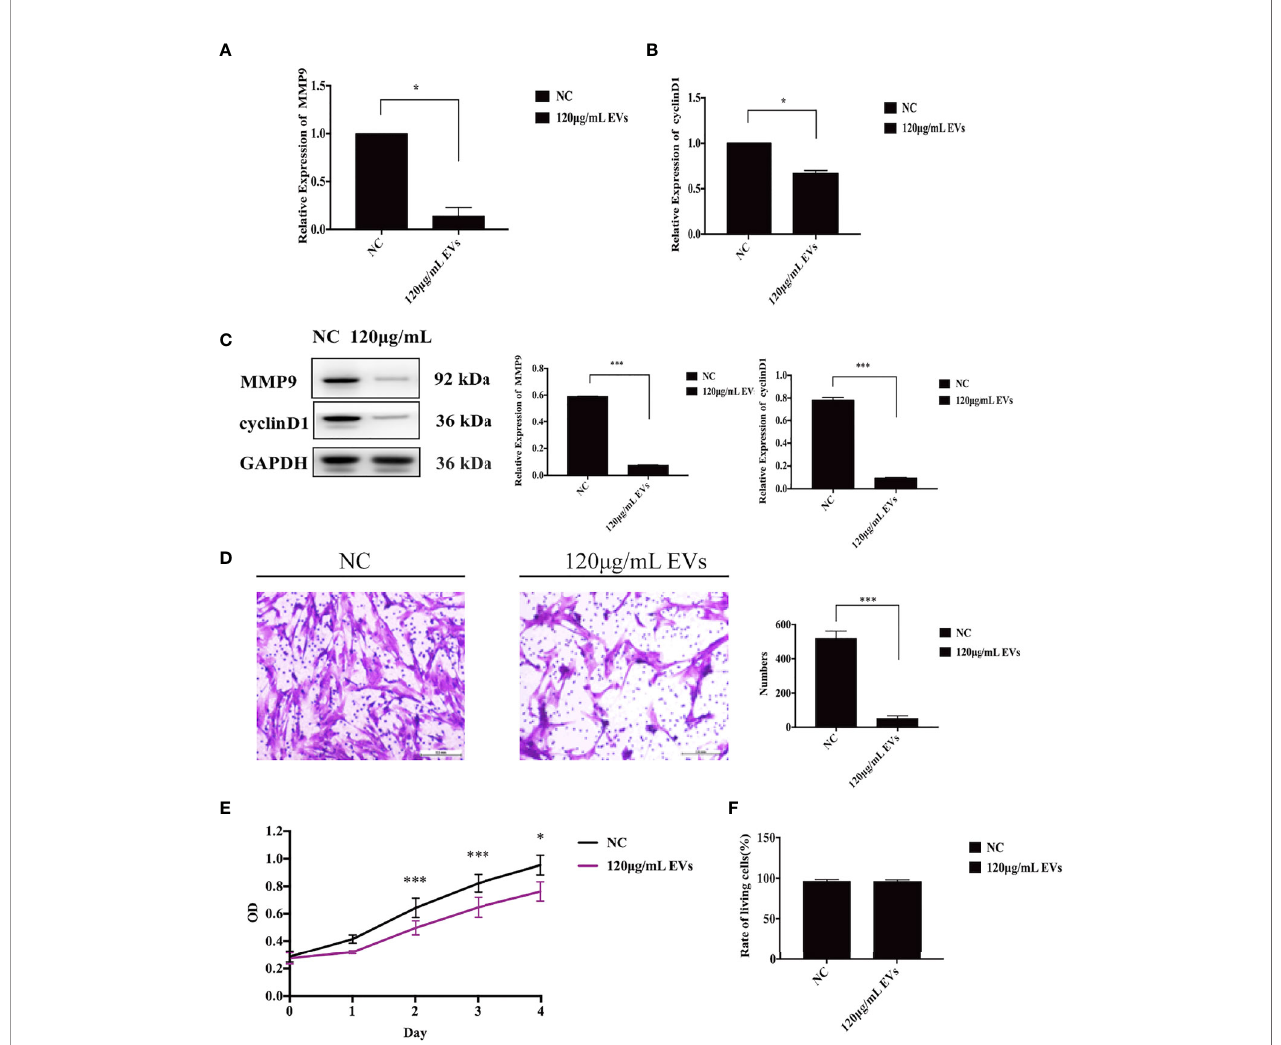
FIGURE 3 | EVs inhibit ESC proliferation and invasion. (A) ESCs were collected for qRT-PCR to detect to mRNA expression of MMP9 (n = 6, P = 0.04), after stimulation with EVs. (B) After stimulation with EVs, ESCs were collected for qRT-PCR to identify the mRNA expression of cyclin D1 (n = 6, P = 0.02). (C) ESCs were collected for western blotting analysis using the anti-MMP9 and anti-cyclin D1 (n = 6, P = 0.000 each). (D) A matrigel invasion assay was used to detect the invasive ability of ESCs. The invasive ability of ESCs exposed to 120 m g/mL EVs showed a 90% reduction (n = 6, P = 0.000). (E) CCK-8 assay was used to assess the proliferative ability of ESCs between days 0 – 4. All experiments were repeated three times. (F) Trypan blue staining was used to assesse the living rate of ESCs. *P < 0.05, ***P < 0.001 vs. individual controls. OD values in CCK-8 assays and cell numbers in Transwell assays were expressed as mean ± standard deviation. Independent sample t-test was used between two groups of